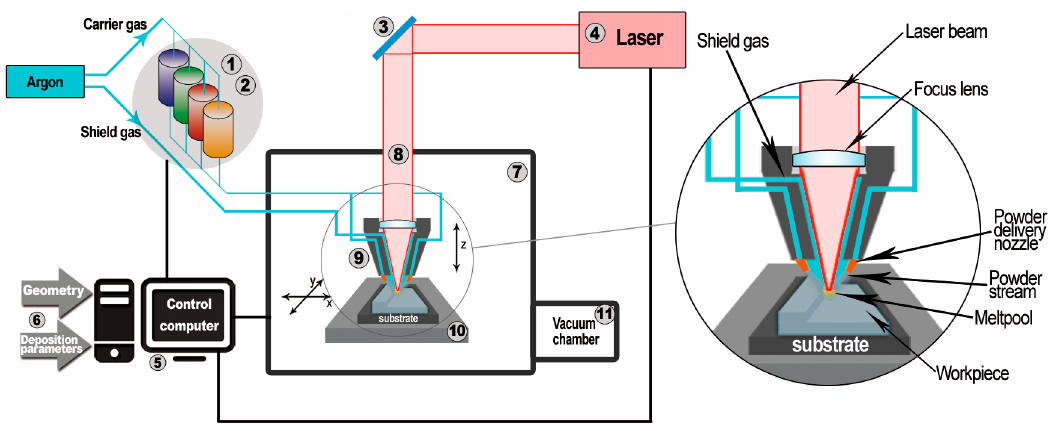
Figure 1. Scheme of the laser-engineered net shaping (LENS) system [17]: 1. Powder supply—it is possible to install and use a four powder supply unit; 2. Pneumatic vibrating system that provides stable powder doses; 3. Optical system for focusing the laser beam, the optical path, and the imager thermal system for analyzing the temperature distribution of the liquid metal; 4. IPG fiber laser with the wavelength of 1070 nm and power of 500 W; 5. Computers for process control; 6. Input data entered by the operator; 7. Working chamber with protective atmosphere with controlled oxygen and water vapor content (less than 10 ppm). Work in the chamber is conducted using butyl gloves and sight glass in the form of transparent plastic with a filter to protect the operator from high-power laser radiation; 8. Optical path of the laser; 9. Working head with four nozzles controlling the flow of powder into the laser beam focus zone; 10. Numerically controlled working table (movement in the X - Y plane); 11. Antechamber with atmosphere purification vacuum system.